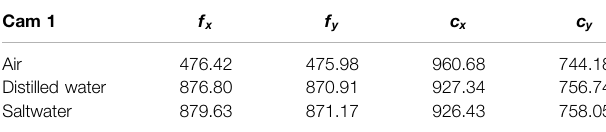
TABLE 1 | Camera calibration parameters in different